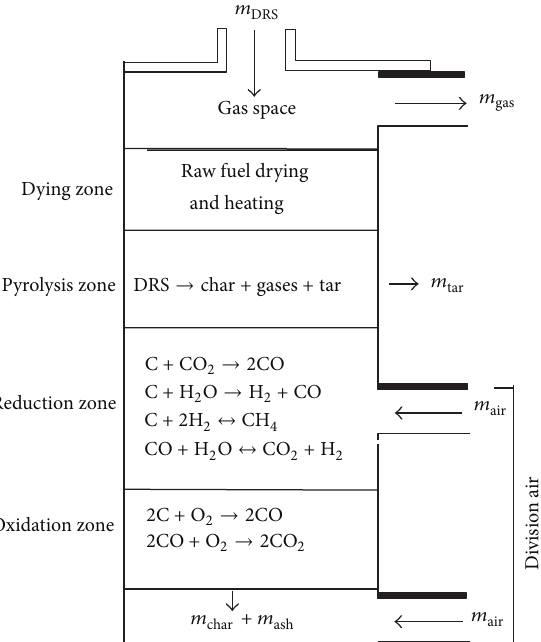
Figure 1: Schematic diagram for exothermic and endothermic reactions in adiabatic updraft